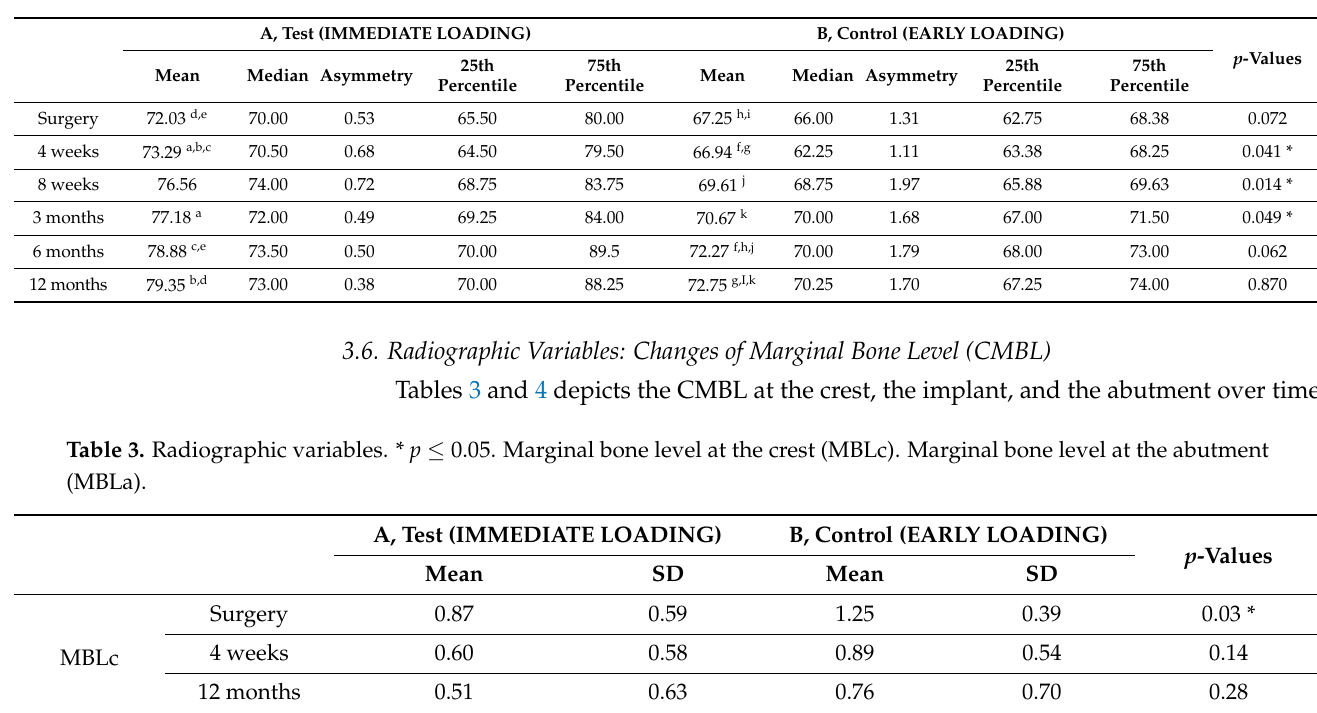
Table 2. Implant quotient stability (ISQ) values at the time of surgery, at 4 and 8 weeks, and at 3, 6, and 12 months. * Statistically significant differences between Groups A and B ( p < 0.05). a–k Statistically significant differences between values with the same letter ( p < 0.05).